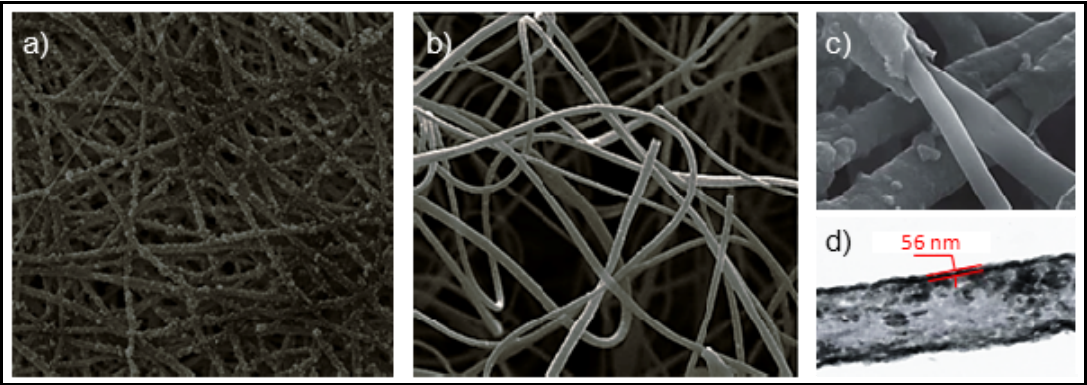
Figure 20. SEM micrographs of ( a ) mesh-PPy scaffold; ( b ) Novel fluffy-PPy scaffold; ( c ) PPy coated PLLA fibers; and ( d ) TEM image of a PPy hollow fiber. Reprinted with permission from [87]. Copyright 2012 Royal Society of